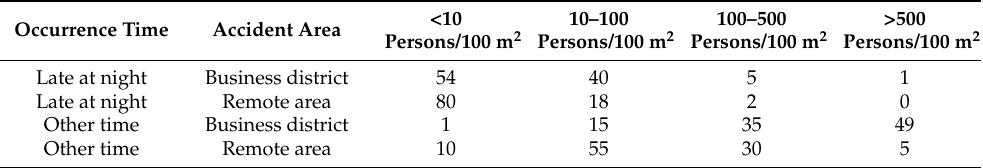
Table 6. Conditional probability table for threatened persons before urbanization.